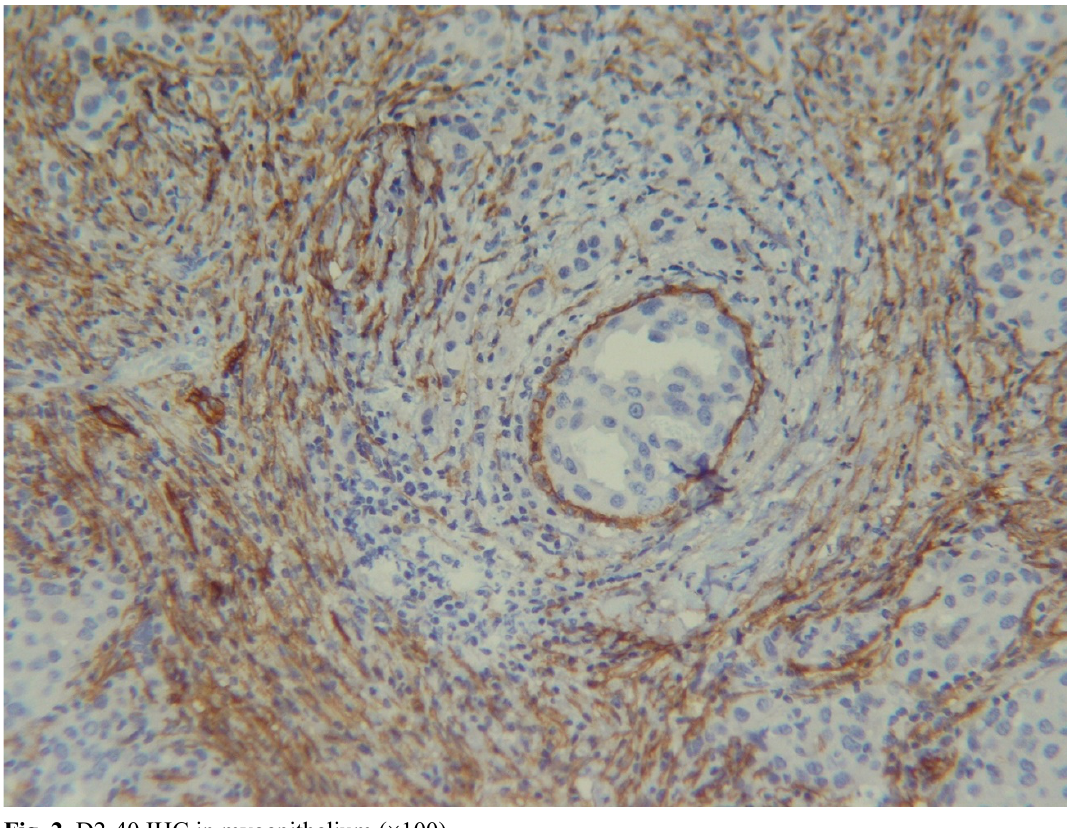
Fig. 2. D2-40 IHC in myoepithelium (×100) Abbreviations: IHC, immunohistochemistry. Table 2. Lymphovascular invasion detection by H&E and D2-40 IHC methods LVI* present in H&E LVI absent in H&E